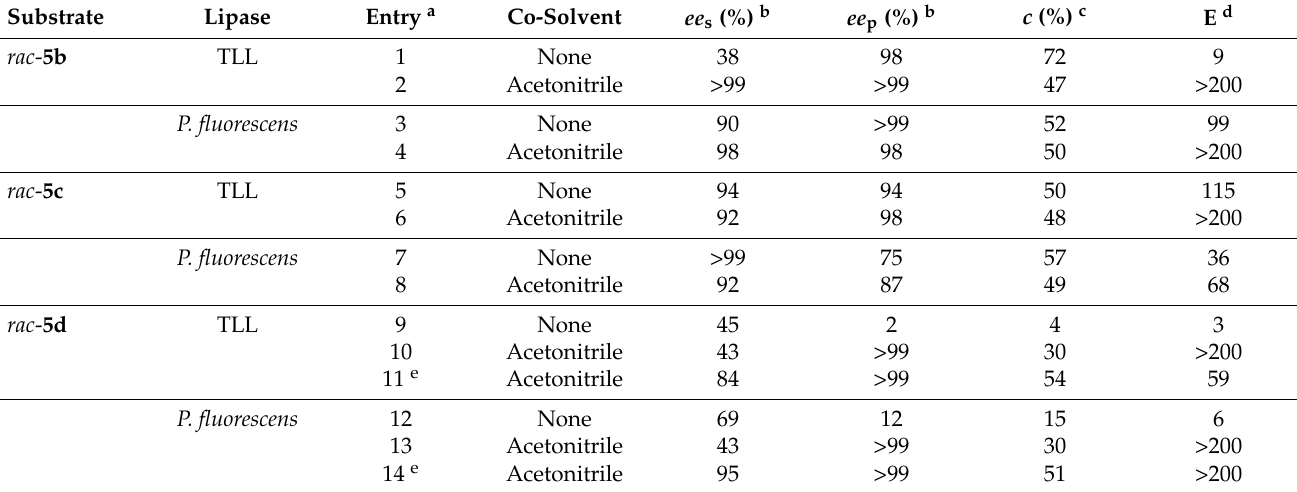
Table 4. KRs of rac - 5b-d via hydrolytic process in the presence of TLL or lipase from P. fluorescens